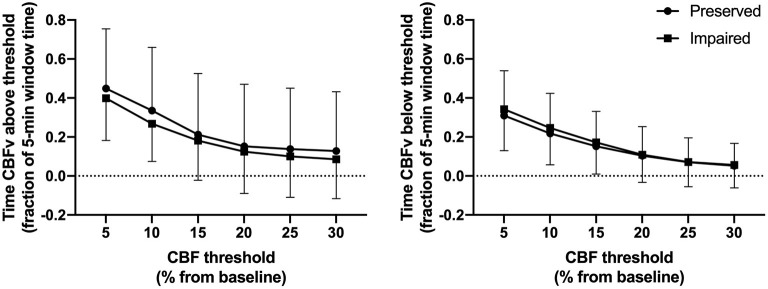
Relationship between CBFv deviations above/below thresholds and state of dynamic autoregulation across patients. Circles denote fraction of the 5-min window used to compute Mxa when autoregulation was preserved. Squares denote fraction of the 5-min window used to compute Mxa when autoregulation was impaired.